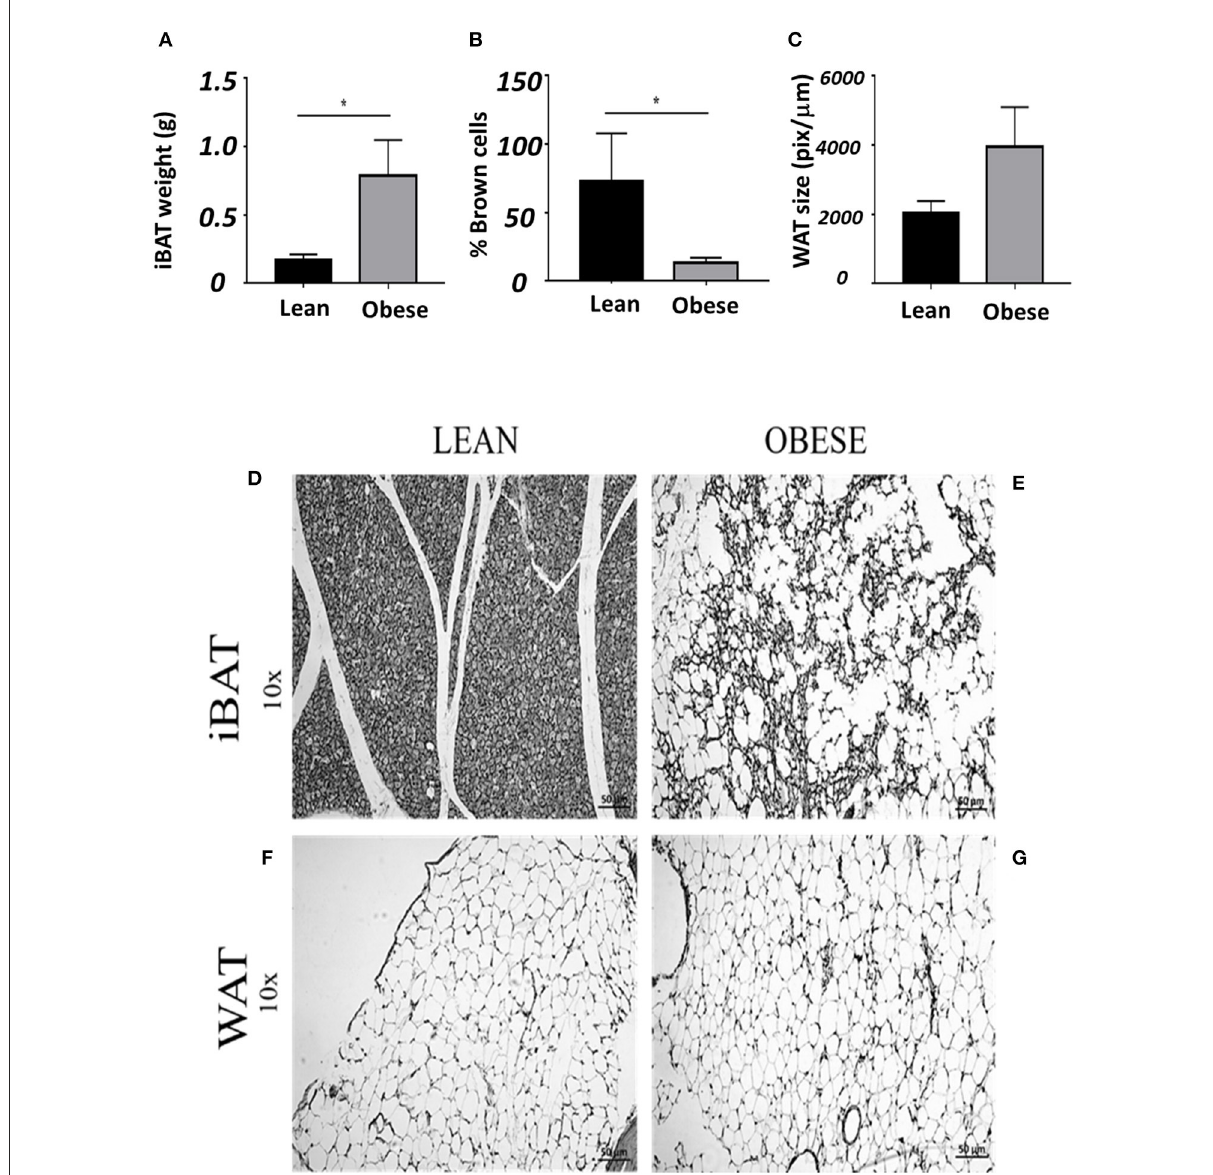
FIGURE5 Average ± SEM of: (A) weigh of iBAT, (B) % of brown adipocytes (C) size of white gonadal adipocytes. (D) Slide of iBAT from a lean, (E) obese iBAT. (F) Gonadal white adipose tissue from lean and (G) obese mice. * Significant differences intergroup lean and obese male mice ( P <